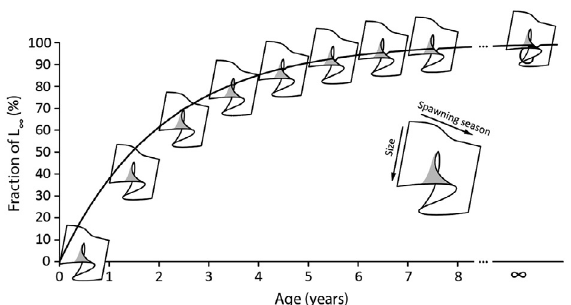
Fig. 4. – A representation of fish growth as a succession of cusps, with the young fish being too small to enter the region (shaded grey) where spawning occurs. This region is approached in pre-adults which may undergo an (abortive) maturation, but fail to spawn. In the year following, however, their size will be higher that than that associated with Q /Q ~ 1.35, and maturation and spawning can proceed. In the m maint following years, size increases are associated with a spawning season that starts earlier and ends later, until maximum size is approached, when spawning often occurs repeatedly, and the body weight is reset at a lower value, which allows growth to be